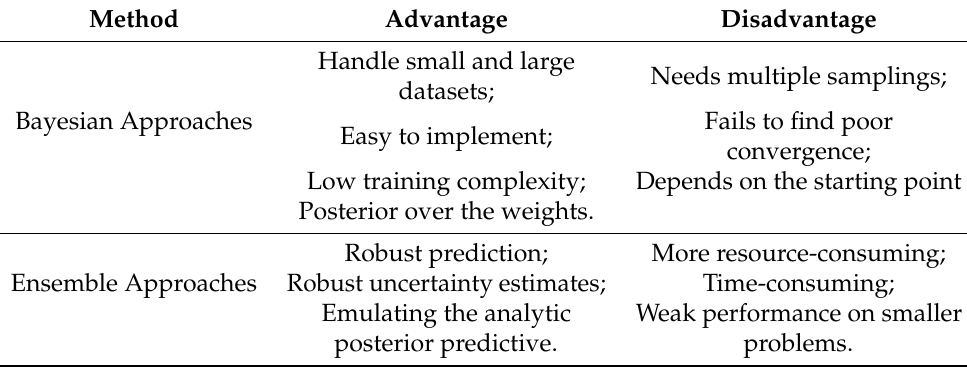
Table 1. Comparison of methods for quantifying